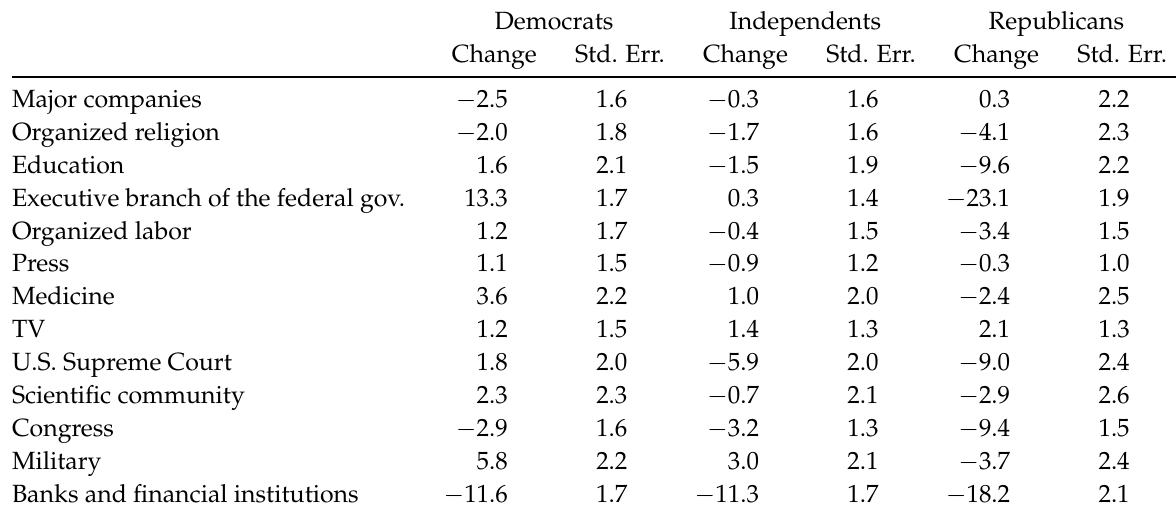
Table 4: Changes between 2004-2008 and 2010-2014 in the Percentage of Respondents with Confidence in Leaders of Institutions Democrats Independents Republicans Change Std. Err. Change Std. Err. Change Std.